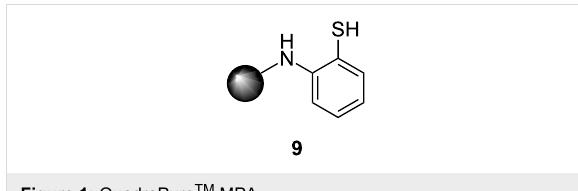
Figure 1: QuadraPure TM MPA.